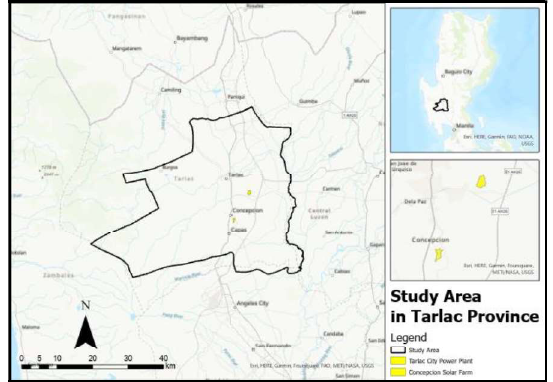
Figure 1. Study area in Tarlac Province, Philippines.